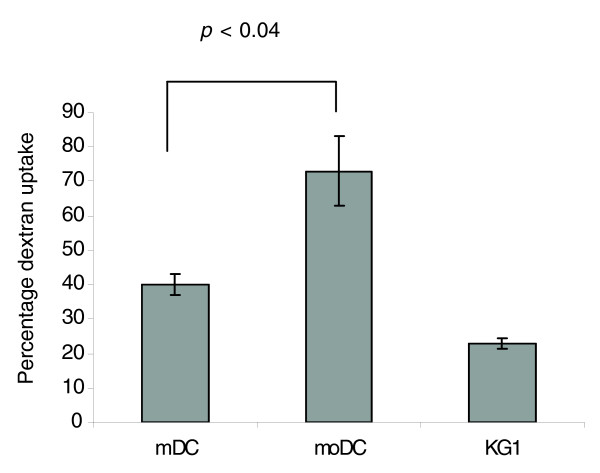
Analysis of endocytic activity using a FITC-dextran uptake assay. Freshly isolated mDCs, moDCs and KG-1 cells were pulsed with dextran for 1 h at 37°C and the uptake was measured by flow cytometry. Data represent average values of three experiments for each cell type.